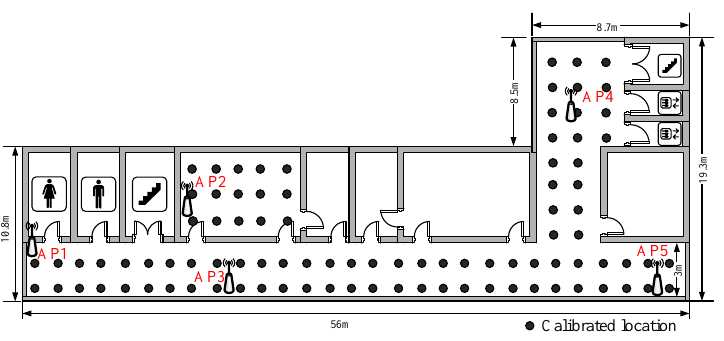
Figure 2. Layout of an indoor